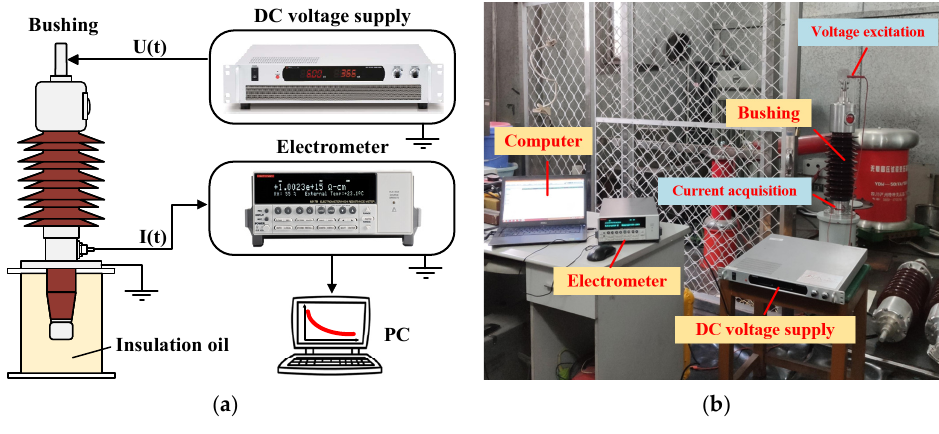
Figure 3. PDC test. ( a ) Schematic diagram; ( b ) Physical diagram.